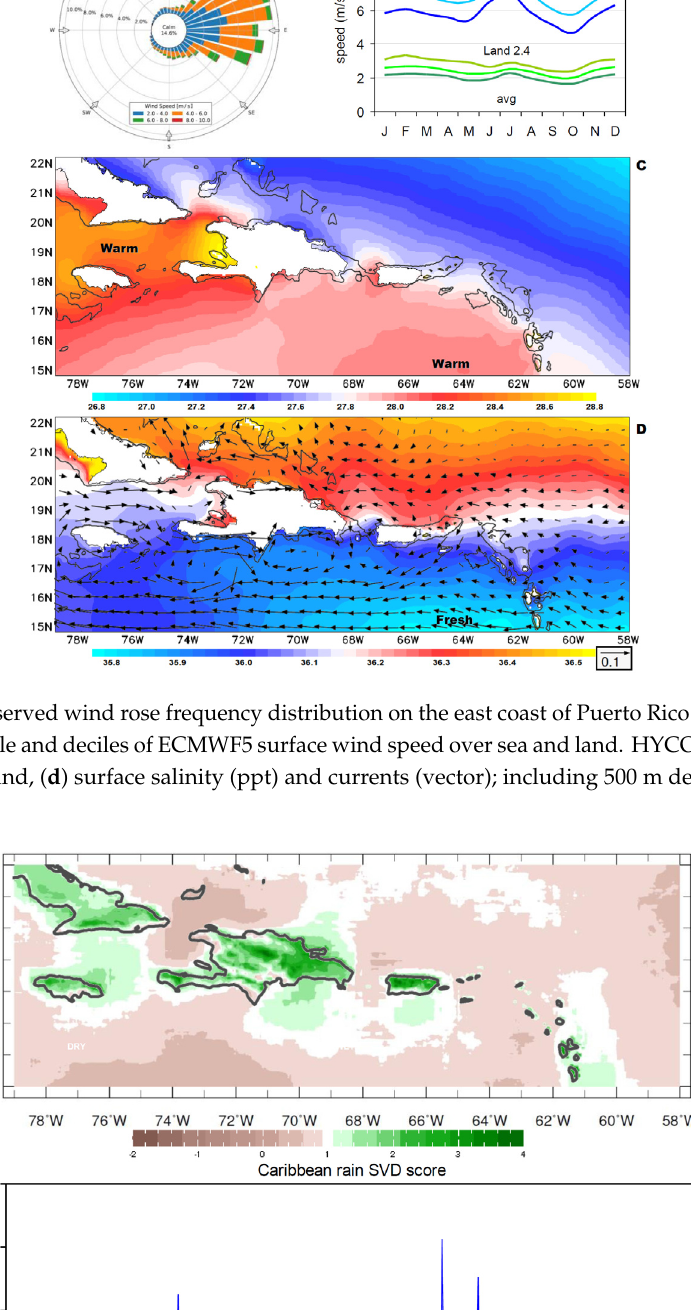
Figure 4. Regression of SVD time score for rain mode-1 Jun-Aug onto fields of: ( a ) net OLR (W/m 2 ), ( b ) SST (°C), and ( c ) 700 hPa zonal wind (m/s).